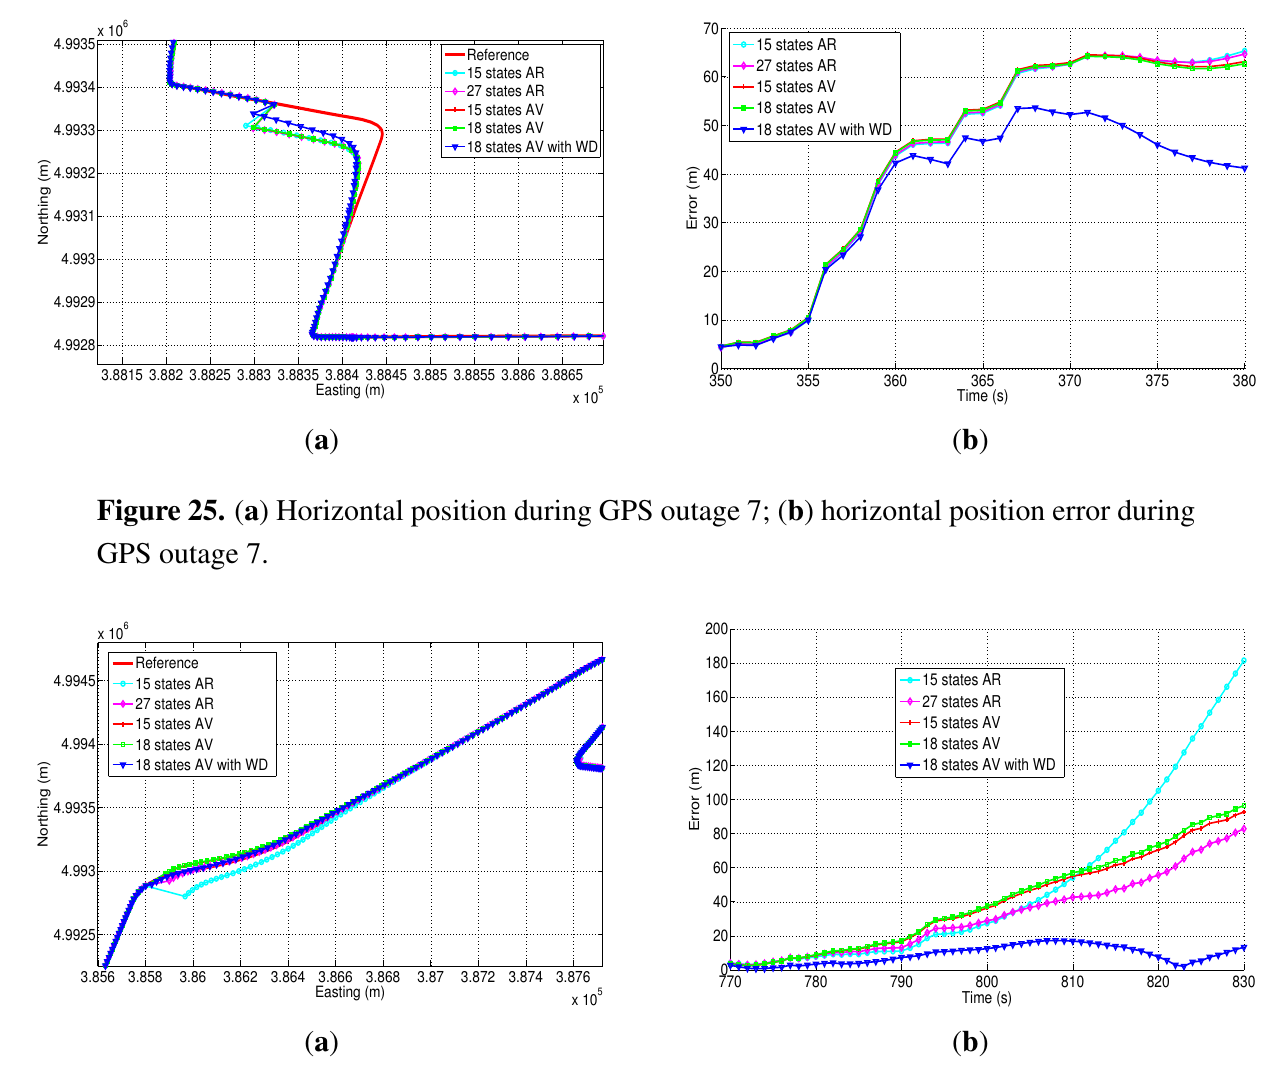
Figure 24. ( a ) Horizontal position during GPS outage 5; ( b ) horizontal position error during GPS outage 5.